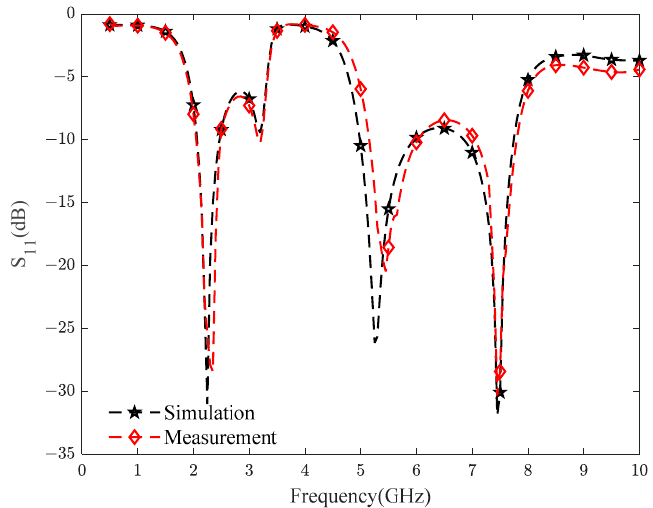
Figure 15. Simulated and measured reflection coefficients of the antenna.